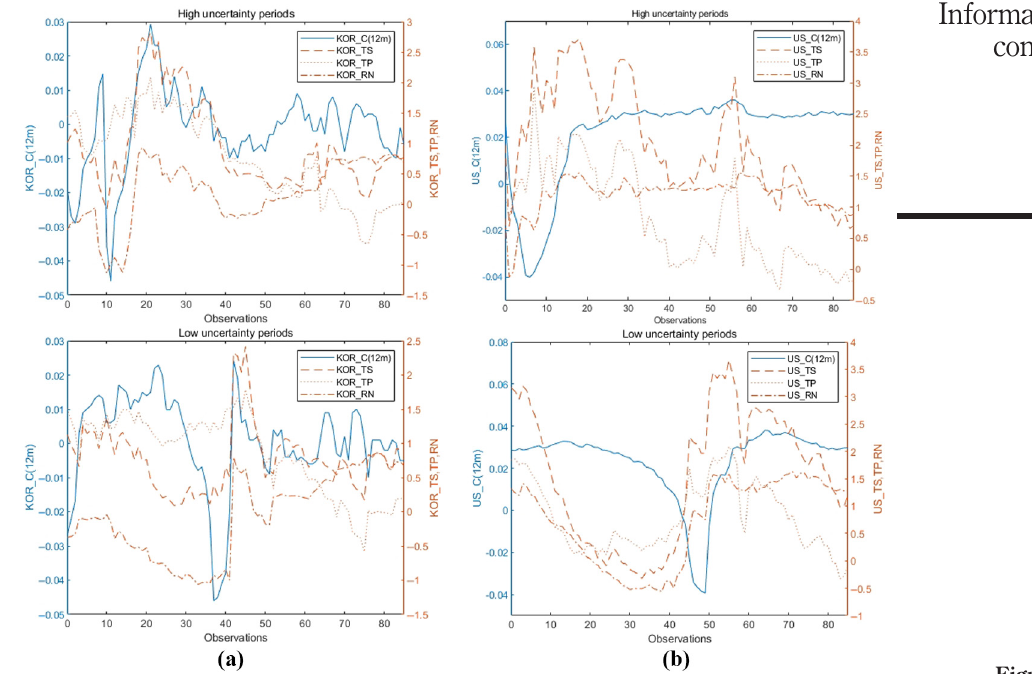
Figure 3. Time-series of growth of coincident economic activity index, term spread and its components with uncertainty in Korea and the